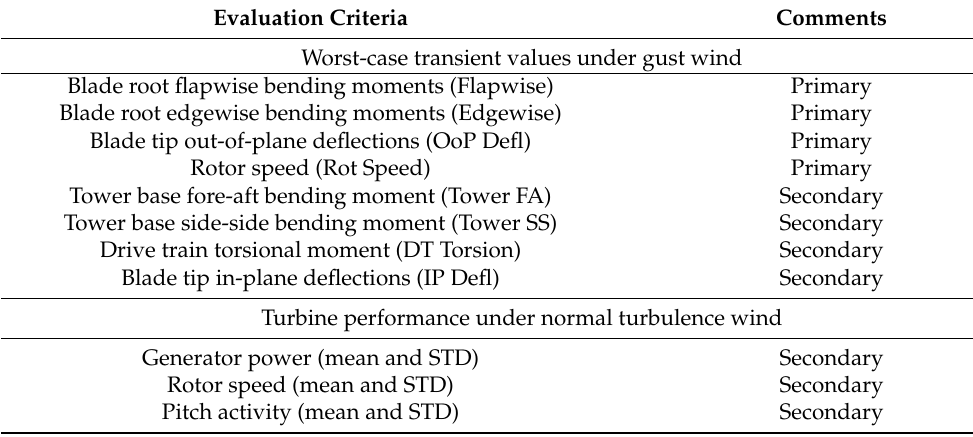
Table 3. Metrics for evaluation.